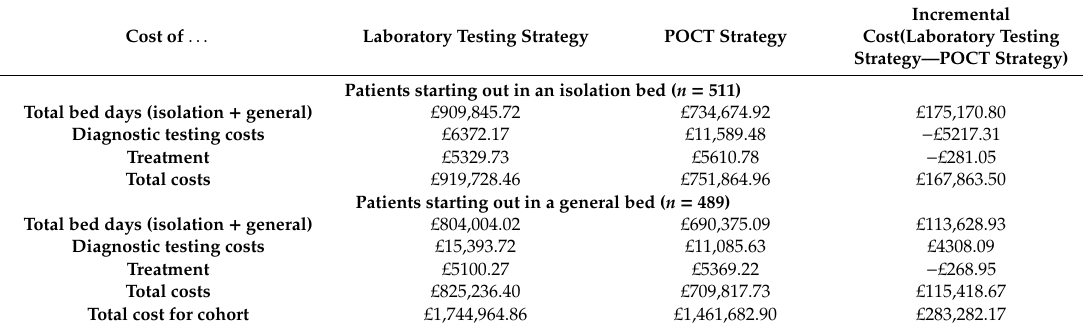
Table 2. Cost analysis of the laboratory testing and POCT strategies for a cohort of 1000 hospitalized patients with suspected infectious